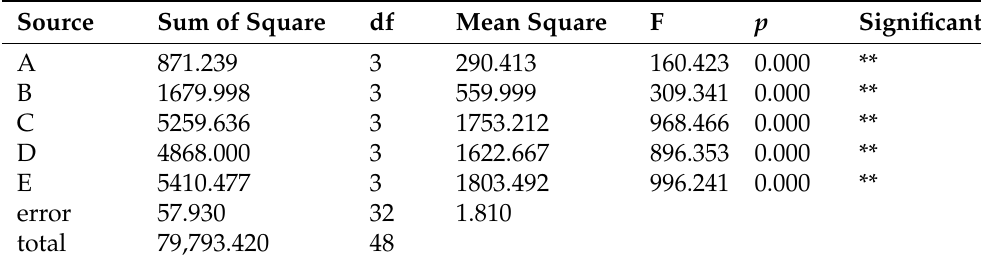
E1 Table 7. Variance analysis of orthogonal test where A – E represent temperature, pH, salinity, inoc- ulation dose of strain, and petroleum hydrocarbon concentration, respectively, and such parameters as degree of freedom, the mean square, and where F: F-value; **: p < 0.01 (F > F0.01 (3.51)) and *: p < 0.05 (F > F0.05 (3.51)) are clearly stated. Source